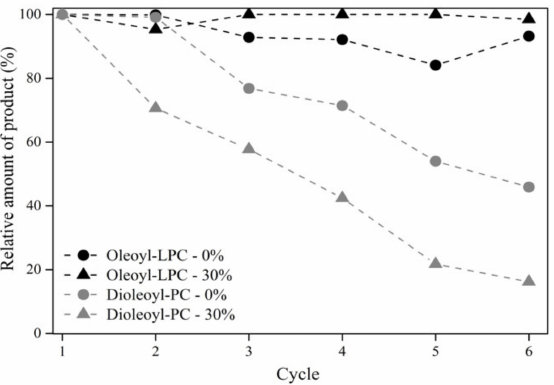
Figure 4. Kinetic curves for successive reuse cycles for Glycerophosphocholine (GPC) esterification with oleic acid catalyzed by Eversa ® Transform 2.0 lipase immobilized on Immobead IB-ADS-3 (ADS3). Dotted lines are presented to improve